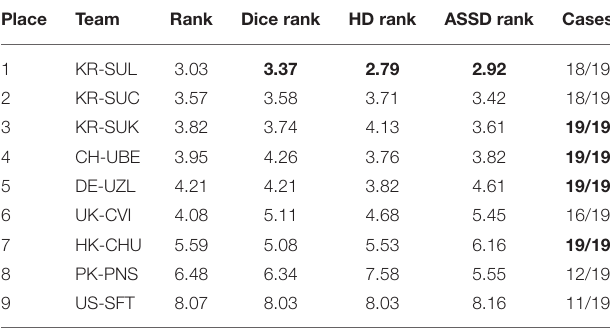
mean values printed in bold.